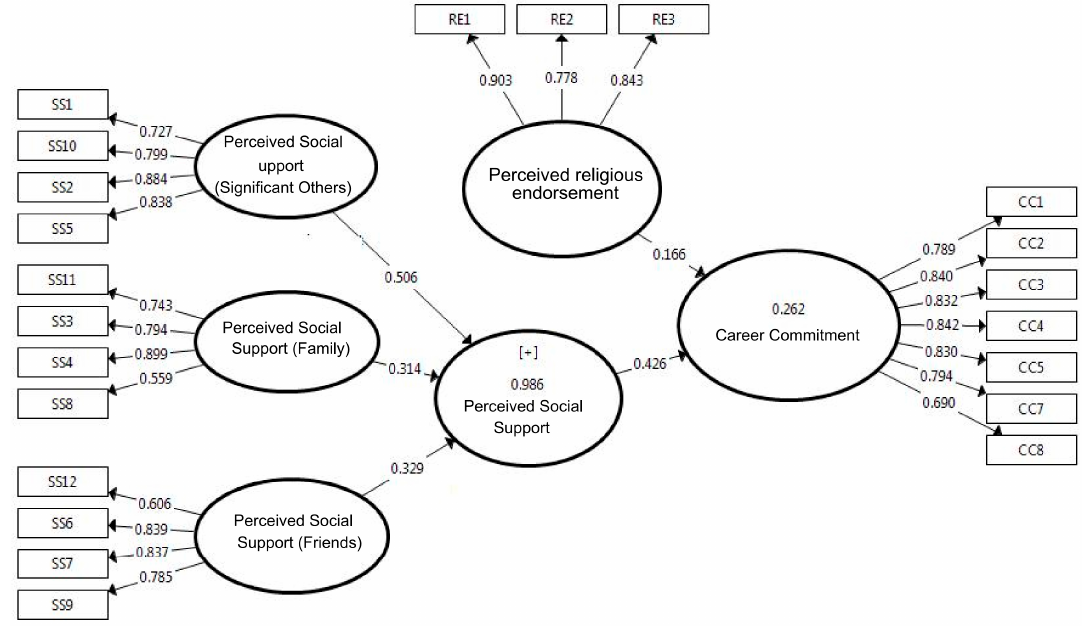
Figure 1. Factor loading of the model. Table 2. Measurement model